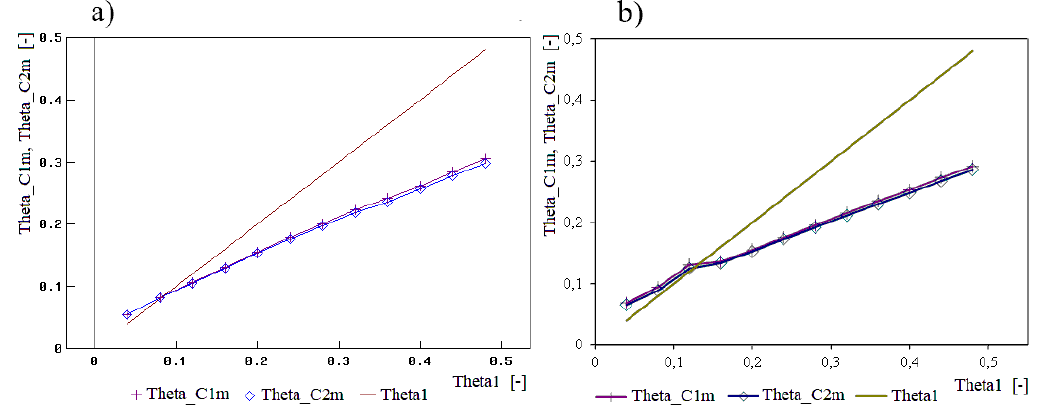
Figure 11: Values of diagnostic parameters ϑ C 1 m (Theta_C1m) and ϑ C 2 m (Theta_C2m) as functions of the dimensionless coeflcient of damp- ing in the suspension system ϑ 1 (Theta1), obtained from an analysis of the factor of gain in the force measured by the real diagnostic tester, i.e. under the exciter (relative to the input force), close to the second natural frequency of the rear “quarter car”: a) results for the linear model; b) results for the nonlinear